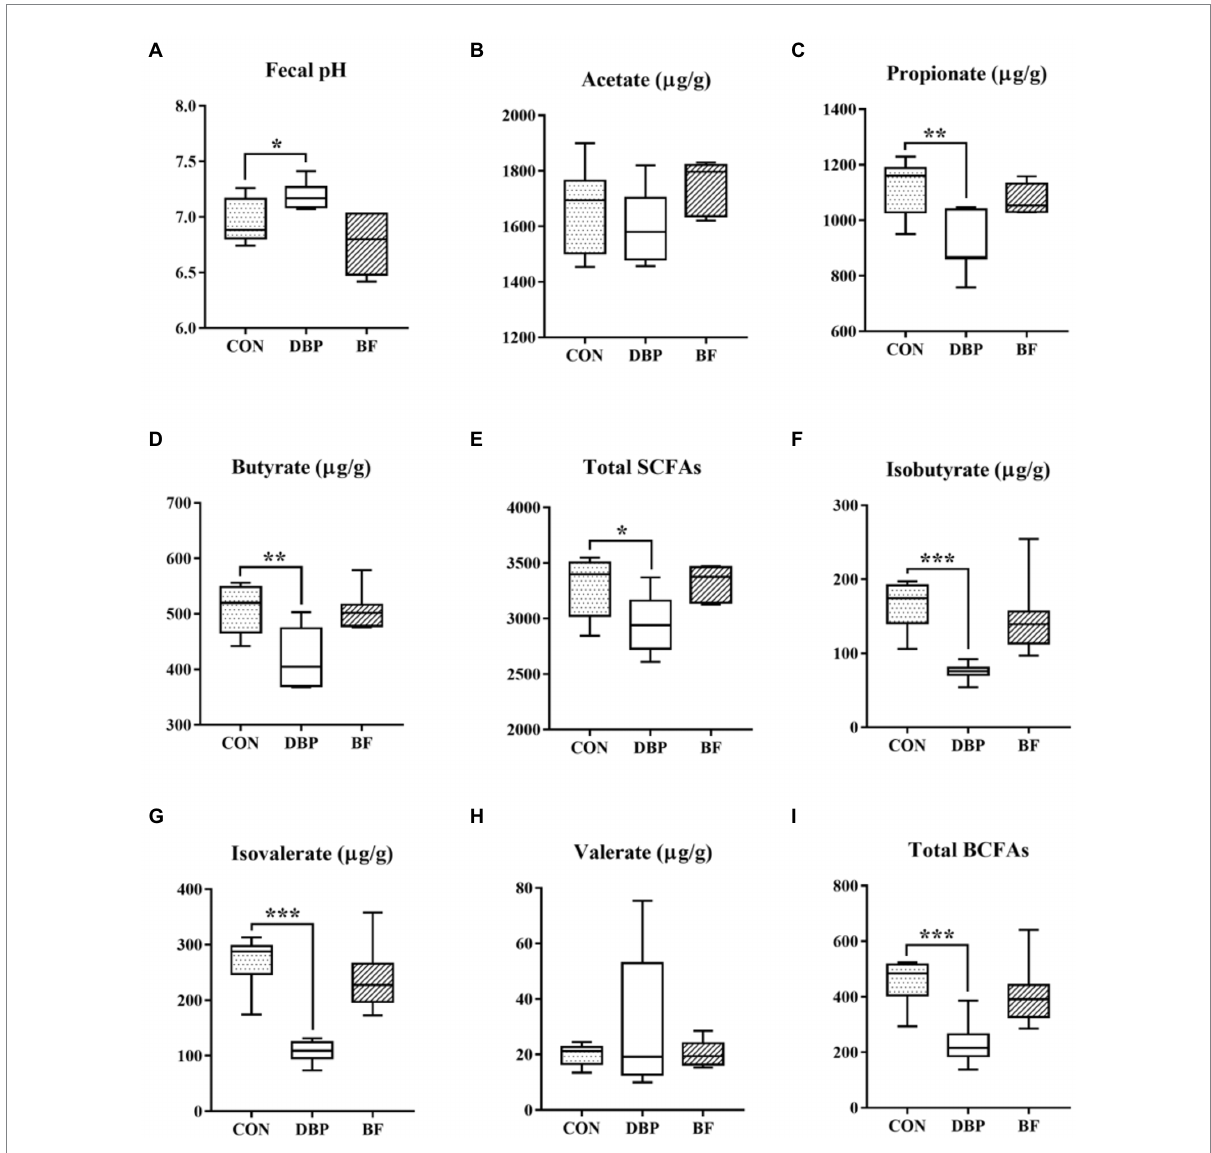
FIGURE 3 Effects of DBP and BF on fecal pH (A) , acetate (B) , propionate (C) , butyrate (D) , total SCFAs (E) , isobutyrate (F) , isovalerate (G) , valerate (H) , and total BCFAs (I) in dogs. Data are presented as mean ± SE ( n = 6, 7, or 7). The symbol (*) indicates a significant correlation (* p < 0.05, ** p < 0.01, and *** p < 0.001). Total SCFAs = acetate + propionate + butyrate; Total BCFAs = isobutyrate + isovalerate +